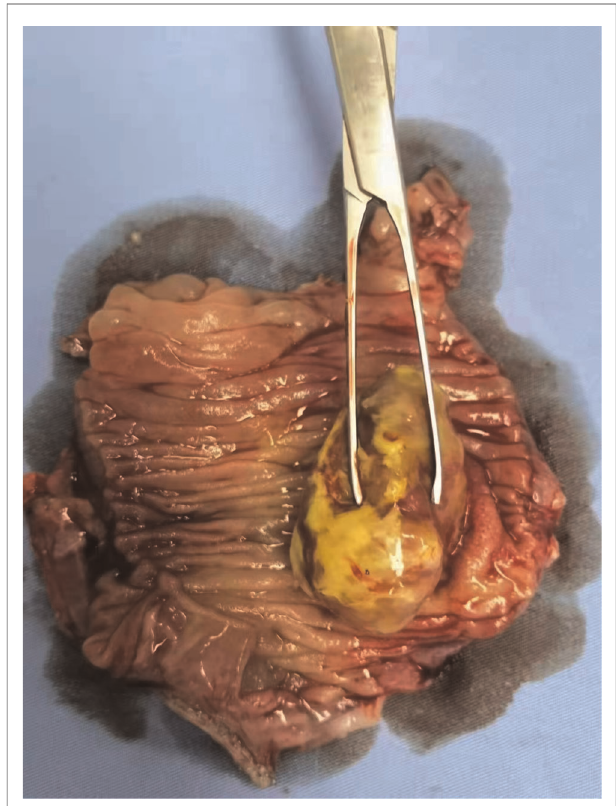
FIGURE 3 | Image showing the cut open specimen and a yellow swelling of about 2×4 cm.